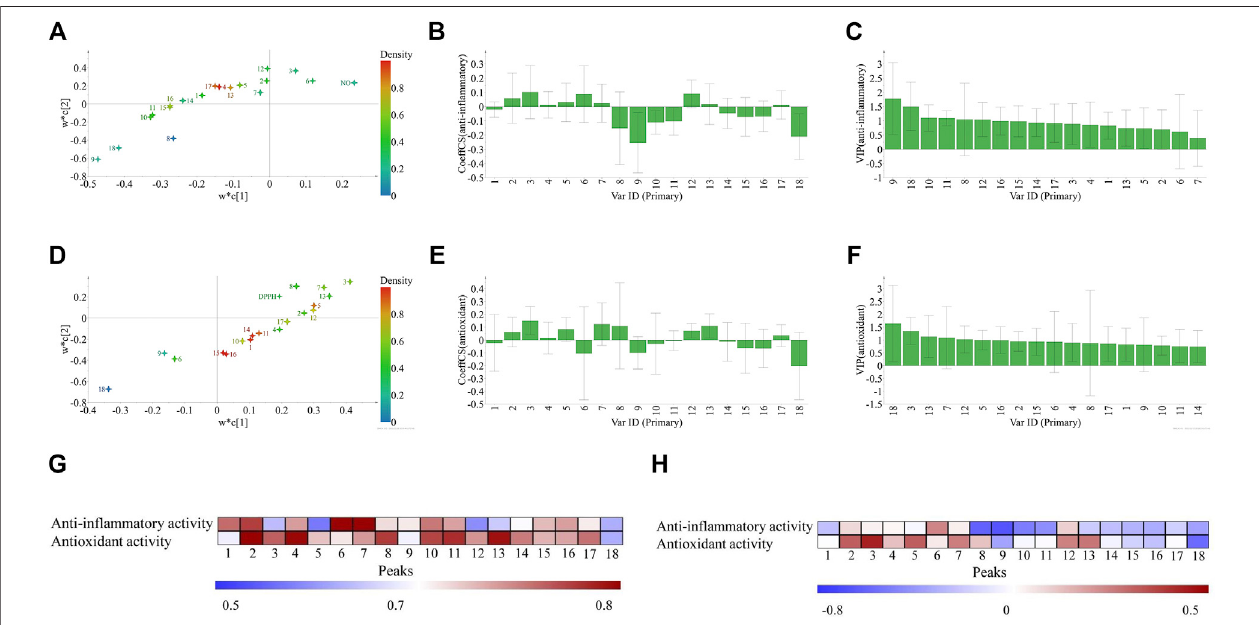
FIGURE 6 | The three pharmacodynamic models to discover principal bioactive components. The results of partial least squares regression (PLSR, A – F ): the loading scatters of PLSR (A : anti-in fl ammatory; D : antioxidant, colored according to density ) ; regression coef fi cient between the 18 common peaks and the anti- in fl ammatory, antioxidant activities,respectively (B :anti-in fl ammatory; E :antioxidant ) ,andVIPvalues (C :anti-in fl ammatory; F :antioxidant ) .Theheatmapofbioactivities of 18 compounds by GRA analysis (G) and Spearman ’ s rank correlation coef fi cient (SRCC) (H) in ZN samples. Peaks 1 – 18 represent the common peaks.